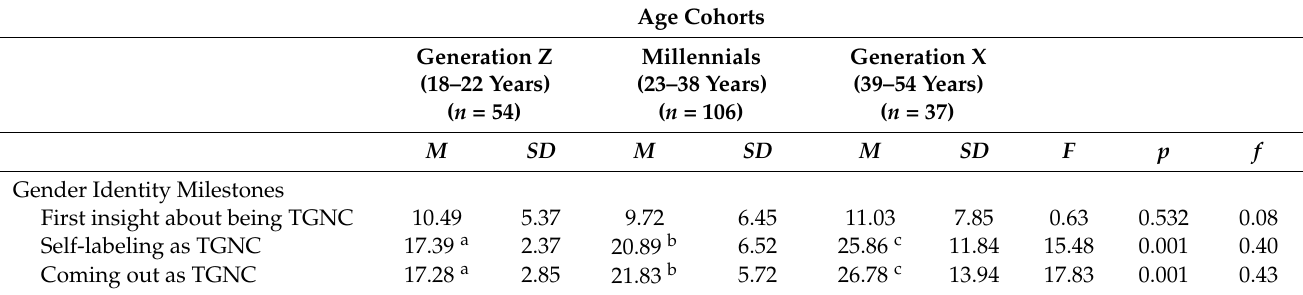
Table 2. Associations between gender identity milestones and generational